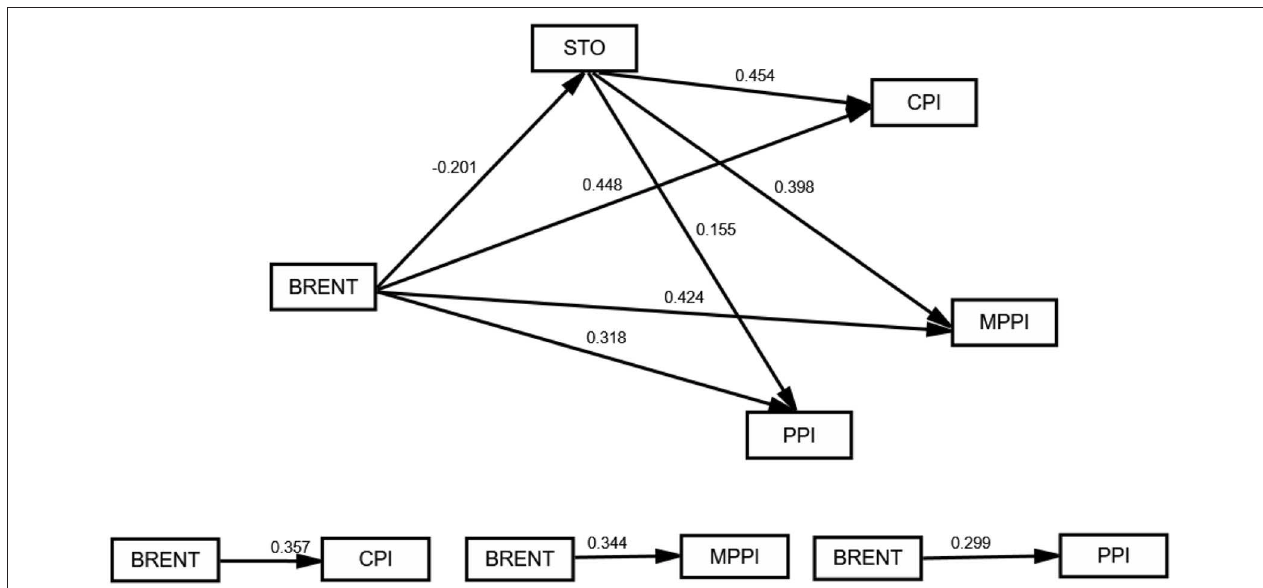
FIGURE 6 | The mediating effect of the financial market. The upper section of the figure reports the direct and indirect effects; the lower section of the figure shows the total